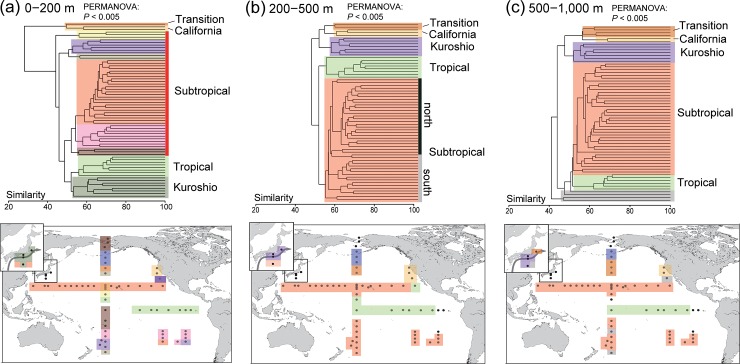
Community compositions at each layer based on presence/absence of operational taxonomic units (OTUs).(a) Epipelagic layer (0–200 m). (b) Upper mesopelagic layer (200–500 m). (c) Lower mesopelagic layer (500–1,000 m). Cluster analyses were performed on warm-water groups. PERMANOVA at each sampling layer was performed on groups color-coded by the region, excluding the unclassified groups (gray) in the lower mesopelagic layer (details in S3 Table). Maps were created by the authors in Generic Mapping Tools version 5 [30].